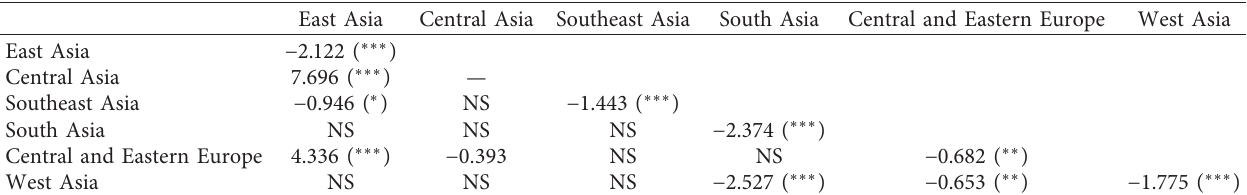
Table 9: Results of OLS regression analysis of the GD 2 within and between subregions.